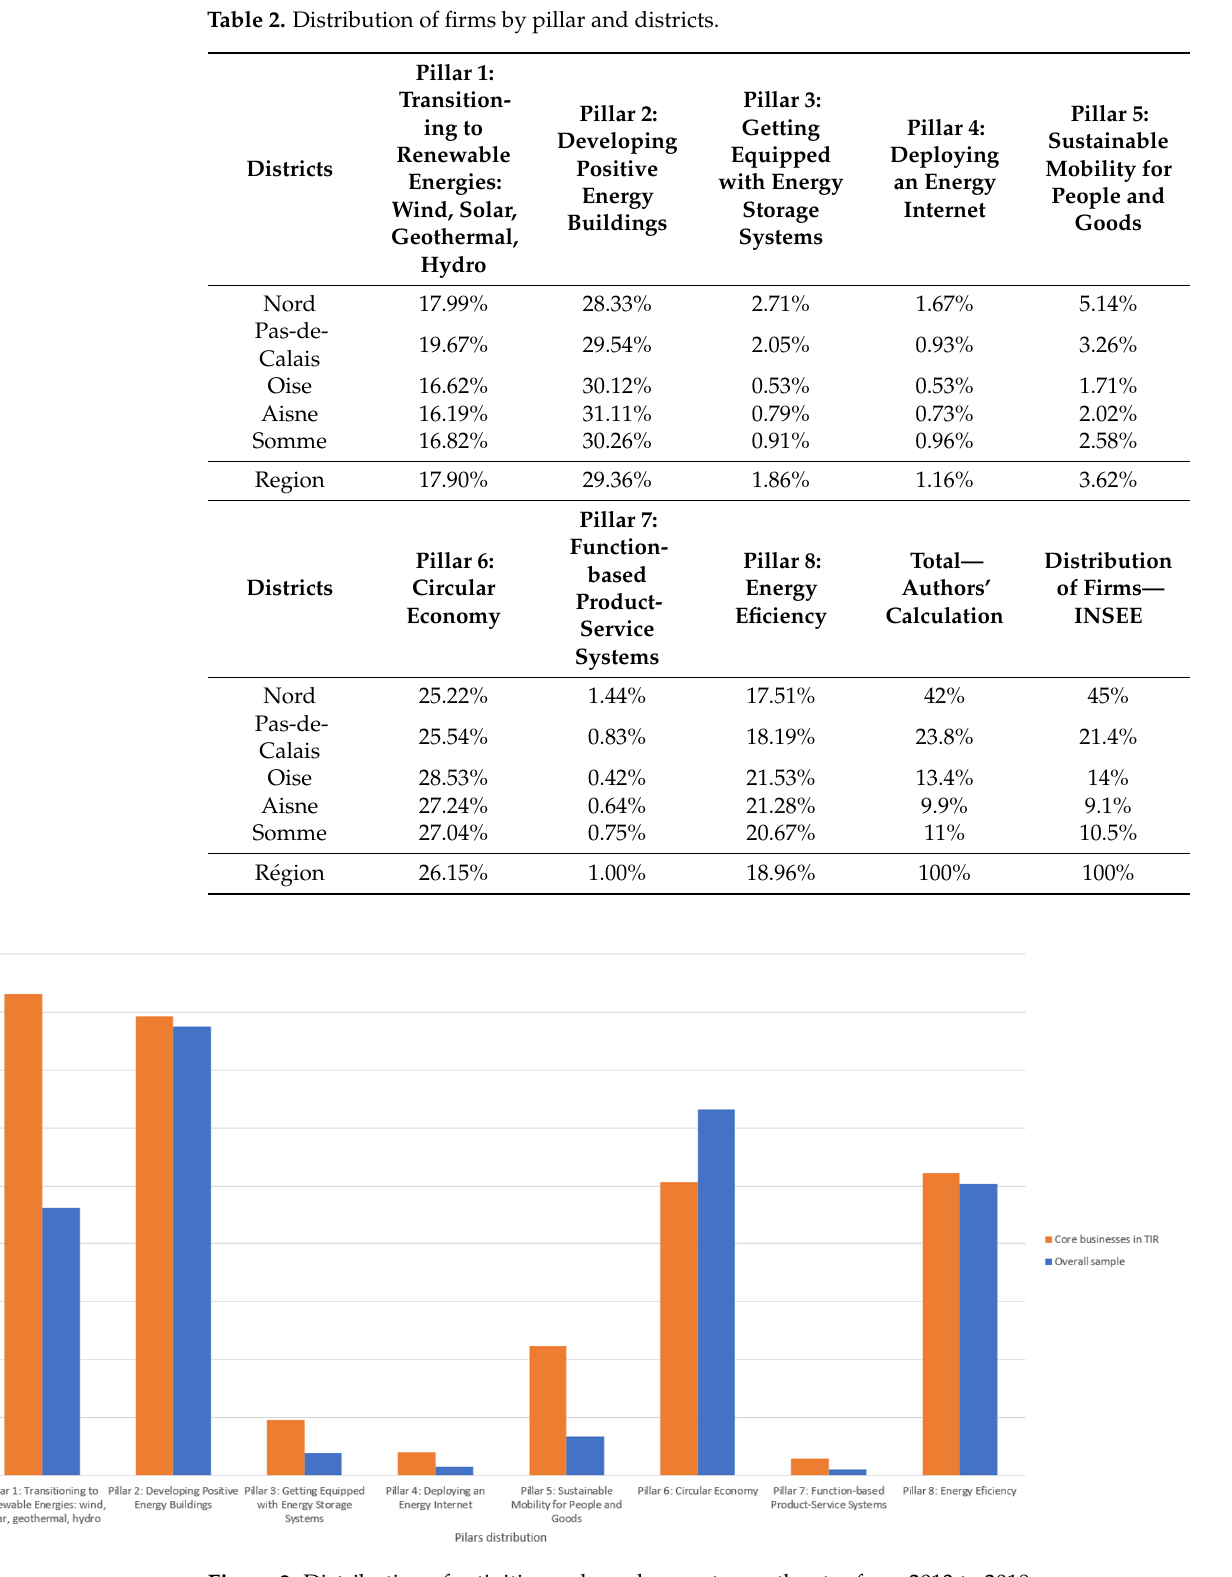
Table 5. Direct job creation by district in Hauts-de-France from 2013 to 2018. Districts